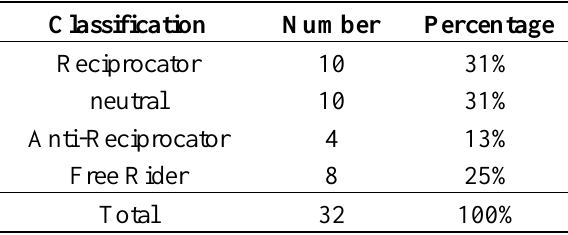
Table 1. Classification of subjects.